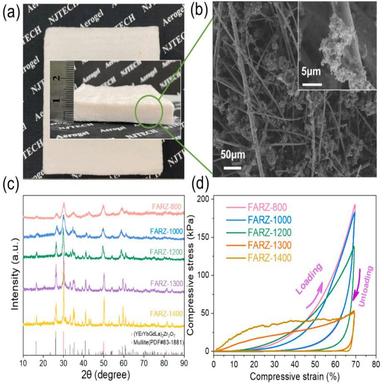
(a) Sample, (b) SEM, (c) XRD (d) the stress-strain curves of FARZ.